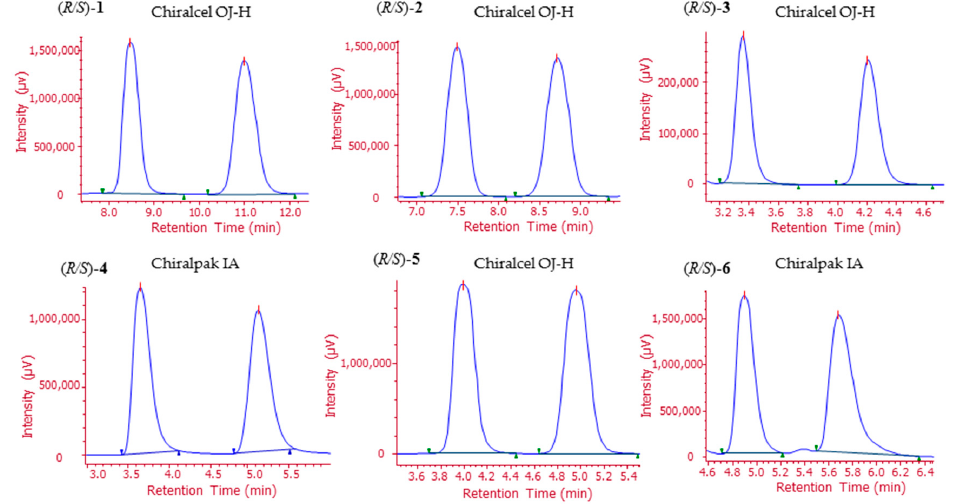
Figure 2. Analytical enantiomer separation of ( R / S )- 1 , ( R / S )- 2 , ( R / S )- 3 , ( R / S )- 5 on Chiralcel OJ-H (4.6 mm × 150 mm, dp = 5 μ m) and of ( R / S )- 4 and ( R / S )- 6 on Chiralpak IA (4.6 mm × 250 mm, dp = 5 μ m). ( R / S )- 1 elution condition: 100% EtOH, DEA 0.1%, flow rate 0.5 mL/min. ( R / S )- 2 , ( R / S )- 3 and ( R / S )- 5 elution condition: 100% MeOH, DEA 0.1%, flow rate 1.0 mL/min. ( R / S )- 4 and ( R / S )- 6 elution condition: 100% MeOH, 0.1% DEA, flow rate 1 mL/min. For all: injection volume 10 μ L.